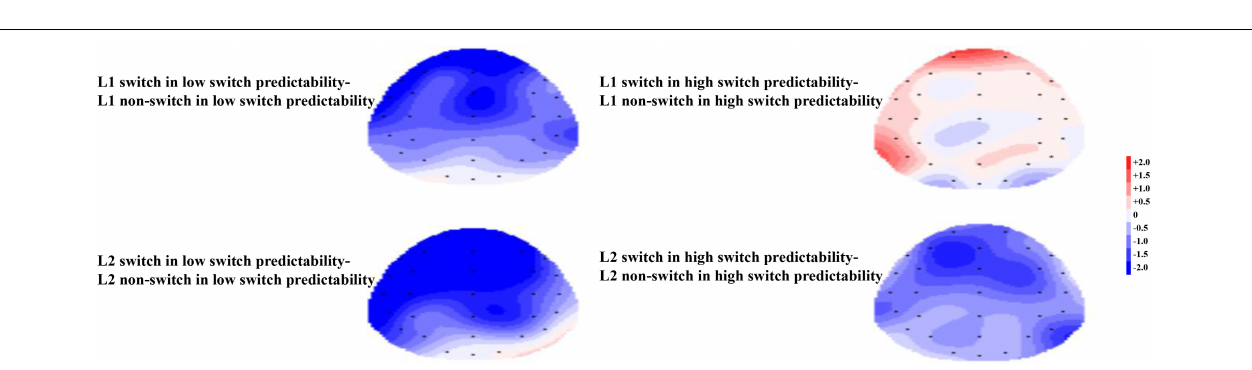
FIGURE 7 | (Left) For the low switch predictability condition, the grand average of the late phase elicited by language cues for naming digits in L1 and L2 at the Cz electrode. (Right) For the high switch predictability condition, the grand average of the late phase elicited by language cues for naming digits in L1 and L2 at the Cz electrode.